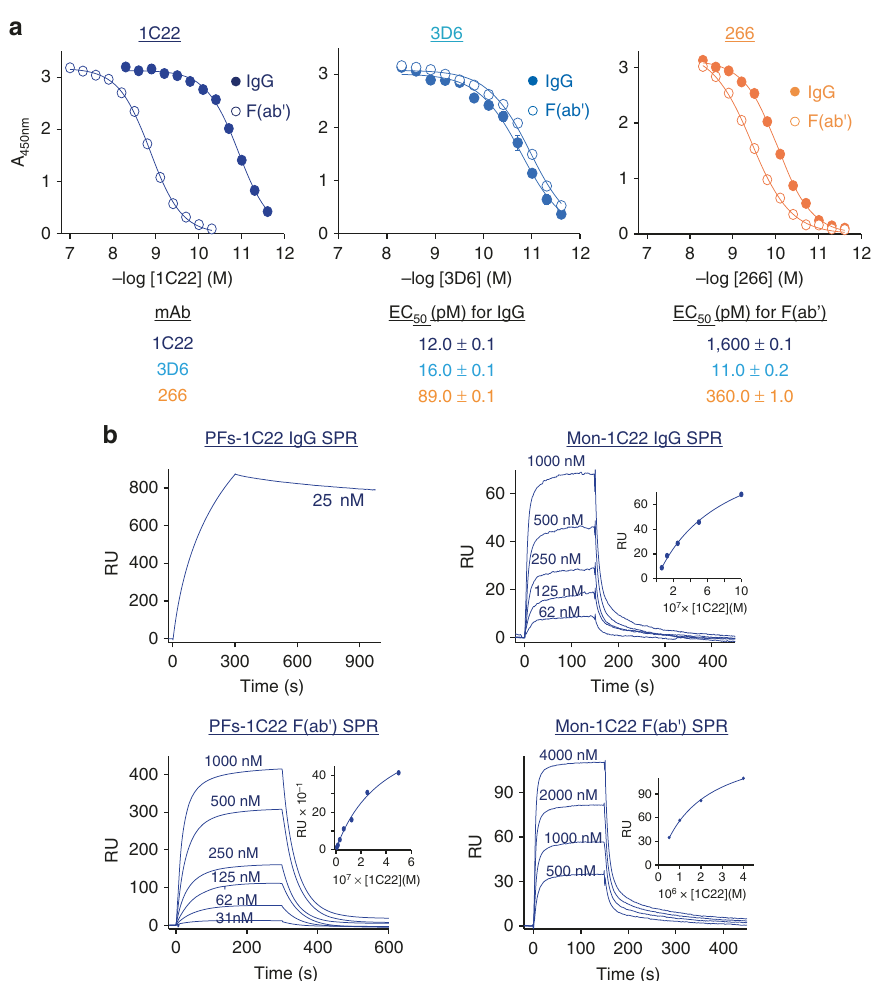
Fig. 3 Bivalency drives 1C22 binding to PFs. a IgG and Fab binding curves for 1C22, 266, and 3D6 against plate-immobilized proto fi brils (PFs). EC 50 values determined from the sigmoidally fi t curves demonstrated that 1C22 IgG had ~130-fold stronger reactivity against PFs than the 1C22 Fab fragment. In contrast, Fab fragments of 3D6 and 266 bound to PFs as strongly as the intact molecules. When error bars are not visible they are smaller than the size of the symbol. Values in the table are in pM and are the average ± SD of each condition analyzed in triplicate. b Representative sensograms for 1C22 IgG (upper panels) and Fab (lower panels) binding to CM5 chip-immobilized PFs (right panels) and monomer (Mon) (left panels) con fi rm that intact 1C22 binds more tightly to immobilized PFs than 1C22 Fab, whereas intact 1C22 and Fab bind similarly to A β monomer. Insets show plots of RU values at steady state for intact 1C22 and 1C22 Fab binding to PFs or Mon. The apparent binding constant of 1C22 IgG for PFs = 0.48 ± 0.002 nM, whereas the binding constant ( K D ) for 1C22 IgG with Mon = 1.39 ± 0.46 μ M, and the K D for IgG Fab binding to PFs and Mon are: 0.80 ± 0.88 μ M,1.14 ± 0.49 μ